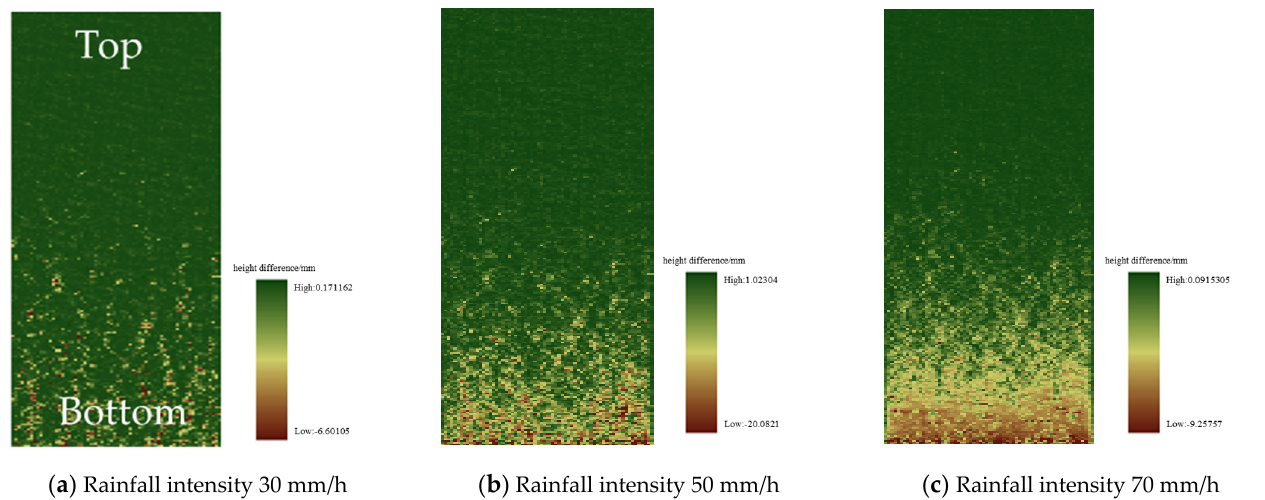
Figure 14. Slope erosion patterns under different rainfall intensity conditions.